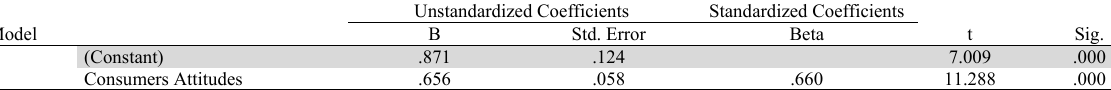
Simple Regression Analysis Between Attitudes and Intention Model